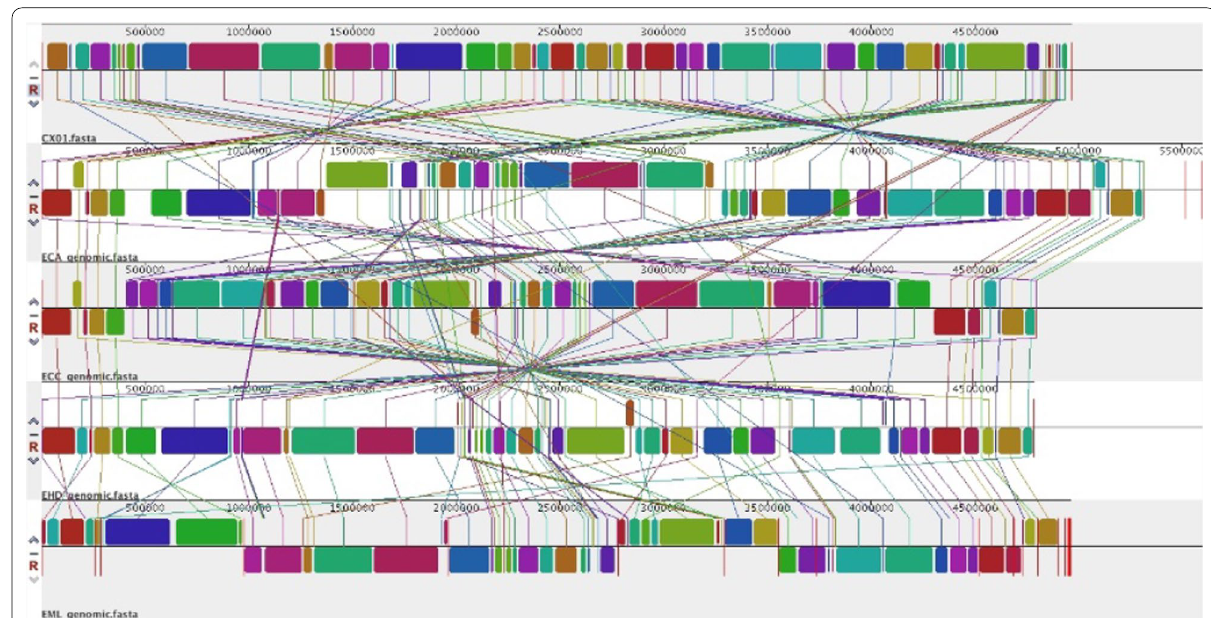
Fig. 3 Genomic alignment of Enterobacter species. Alignment of the genome sequences of E. mori LMG 25706 (EML), E. mori CX01 (CX01, CP055276), E. cloacae ATCC 13047 (ECA, NC_014121.1), E. hormaechei DSM 16691 (EHD, NZ_CP017179.1) and E. cancerogenus CR-Eb1 (ECC, NZ_ CP025225.1) with MAUVE software (Darling et al. 2004). Same color boxes represent homologous regions of the sequences, and are connected by